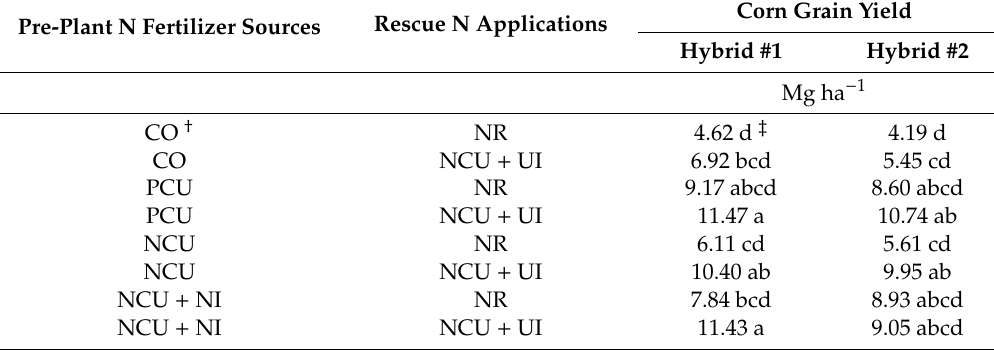
Table 5. E ff ects of pre-plant N fertilizer sources, hybrids and rescue N applications on corn grain yield in 2015. Pre-Plant N Fertilizer